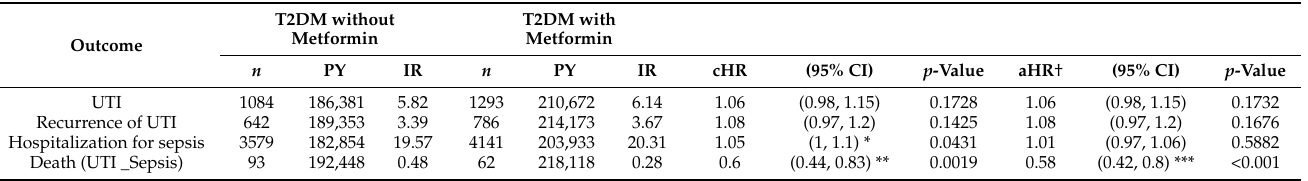
Table 2. Hazard ratios (HRs) and 95% confidence intervals (CIs) for outcomes among the sampled patients.